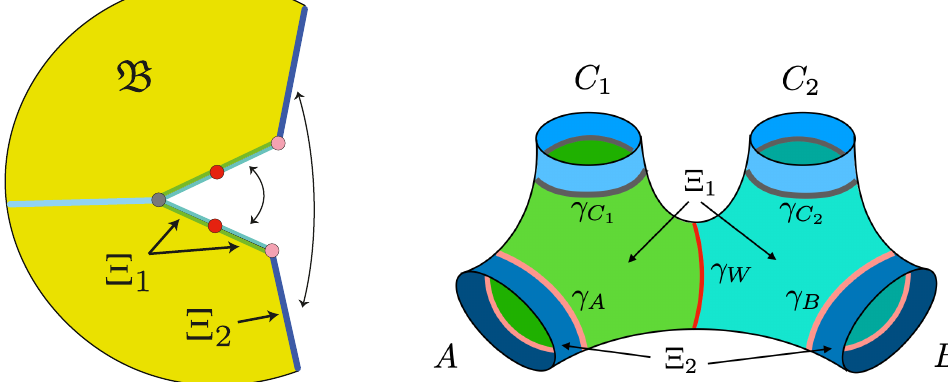
Figure 5 . A fixed-area Euclidean saddle B (left) computing the norm of the state | ψ i representing a four boundary wormhole (right). Due to fixed-area boundary conditions at the relevant surfaces γ A,B,C,W , generically the saddle consists of conical defects at these locations. The Z 2 symmetric slice of the saddle is a Cauchy slice Ξ of the wormhole geometry with shaded regions and extremal surfaces represented on either side. The surfaces Ξ (light and dark green) and Ξ (dark blue) are 1 2 identified as shown, but can be cut open to use as a building block for the replica